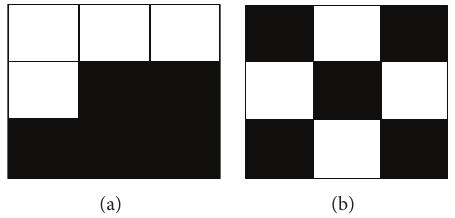
Figure 9: Two examples of calculating chaos degree: (a) its chaos degree is 4 and this pattern has a good quality; (b) its chaos degree is 12 and this pattern is a noise pattern and will bring about